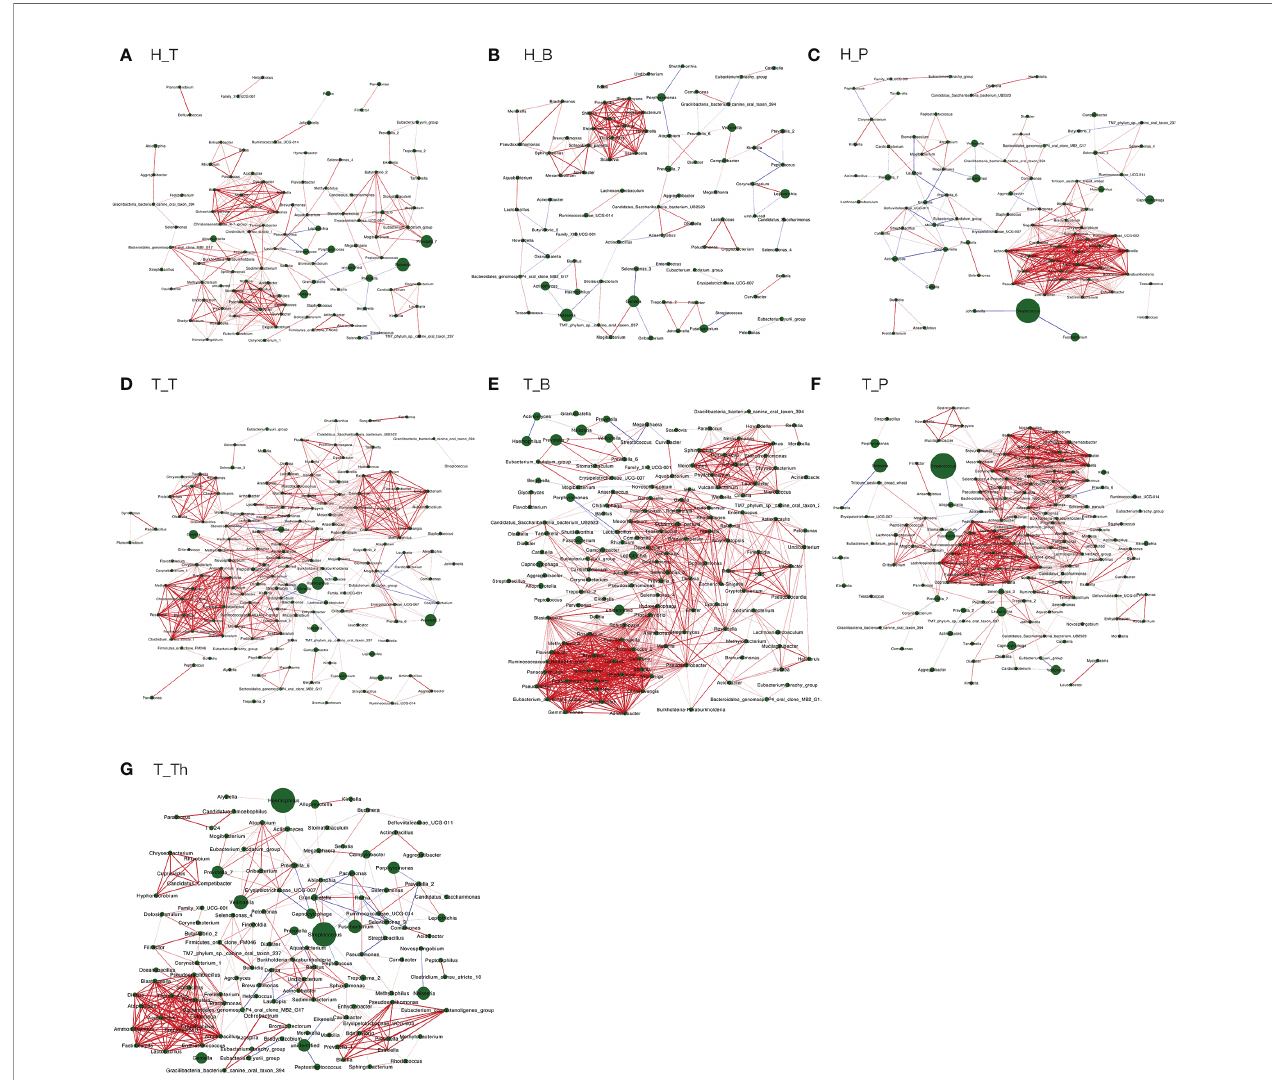
FIGURE 3 | Co-occurring network and corresponding OTUs within each subgroup. (A) H_T, (B) H_B, (C) H_P, (D) T_T, (E) T_B, (F) T_P, and (G) T_Th. Correlations with Spearman correlation coef fi cient |r| > 0.6 and p < 0.01 are shown. Red and blue edges indicate positive and negative correlations. The width of each edge is proportional to the absolute value of Spearman ’ s correlation coef fi cients. The area of each node is proportional to the corresponding OUT ’ s relative